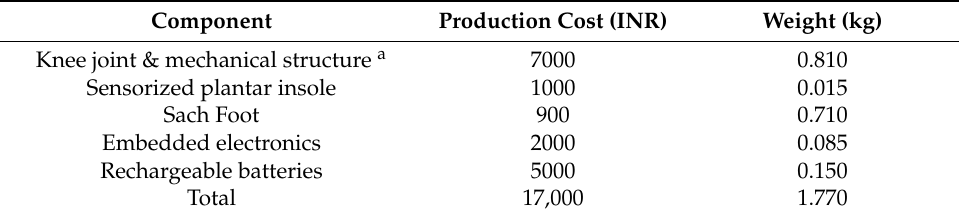
Table 4. Manufacturing cost and weight of various